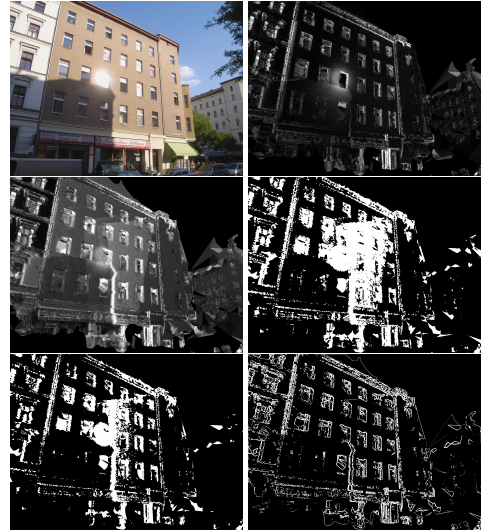
Figure 6. From top left to bottom right: fac¸ade image, visualiza- tion of colour differences to neighbouring images only, visualiza- tion of colour differences to complete sequence, segmentation of colour difference image using the 0 . 7 and 0 . 8 quantile of pixels unequal 0 , image with gradient magnitudes.